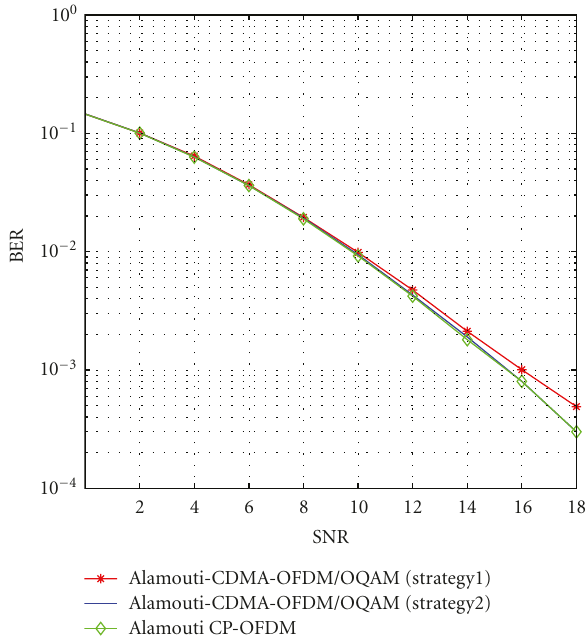
Figure 10: BER for two complex versions of the Alamouti CDMA- OFDM/OQAM with spreading in time domain, versus Alamouti CP-OFDM for transmission over the 7-path frequency selective